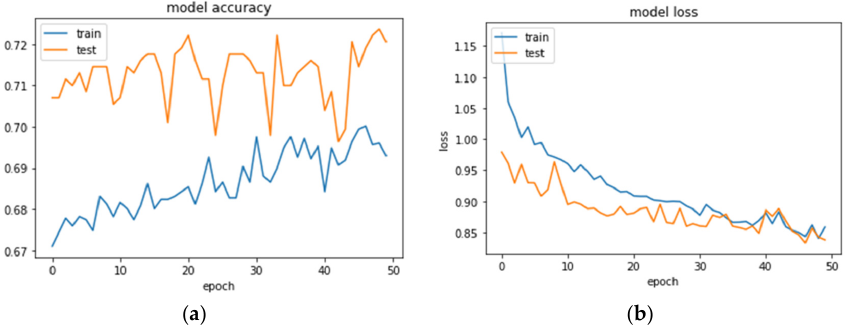
Figure 17. Training and testing of MLP + DA model: ( a ) training and testing accuracy, ( b ) training and testing loss.